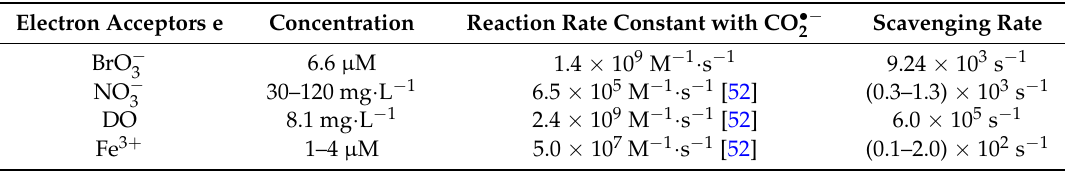
Figure 11. Effects of common electron acceptors on the removal of bromate by UV/BiOCl-HAP SM / formate. Control blank (CB) conditions: [Formate] 0 = 4 mM; BiOCl-HAP SM dosage 0.5 g · L − 1 , [ BrO (cid:2871)(cid:2879) ] 0 = 6.63 μ M, pH = 7.0 ± 0.1, 25 °C, reaction time 15 min. Table 1. Scavenging of CO •− by different electron acceptors. 2